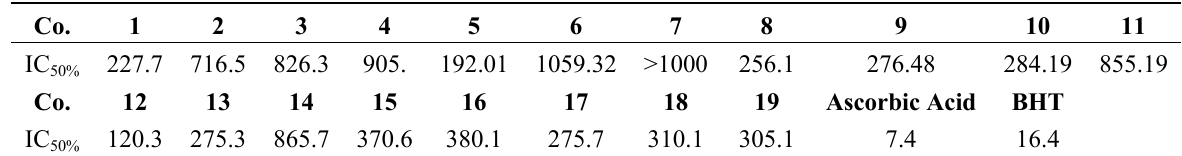
Table 2. The concentration of compound needed to scavenge 50% of the DPPH (IC expressed in